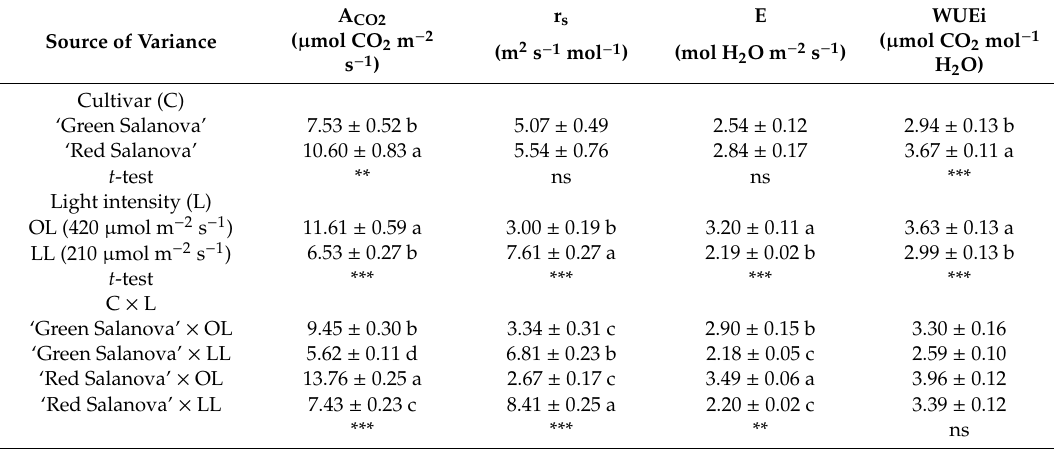
Table 2. E ff ect on the light intensity (optimal light: OL; low light: LL) on net CO 2 assimilation rate (A CO2 ), stomatal resistance (r s ) stomatal conductance (E), and intrinsic water use e ffi ciency (WUEi). All data are expressed as mean ± s.e.; n =